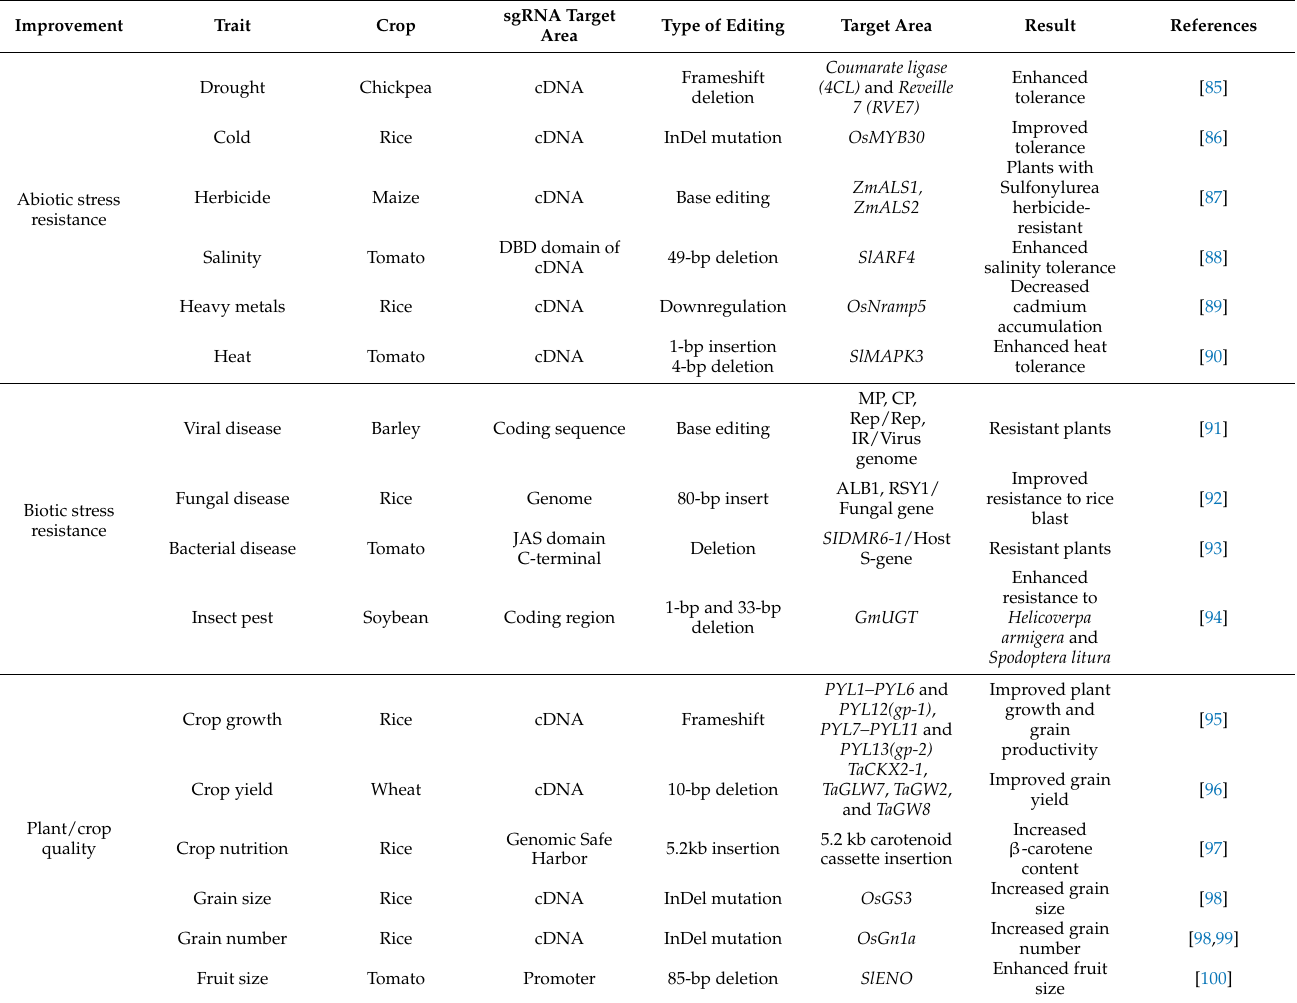
Table 1. Examples of CRISPR/Cas9 applications for crop